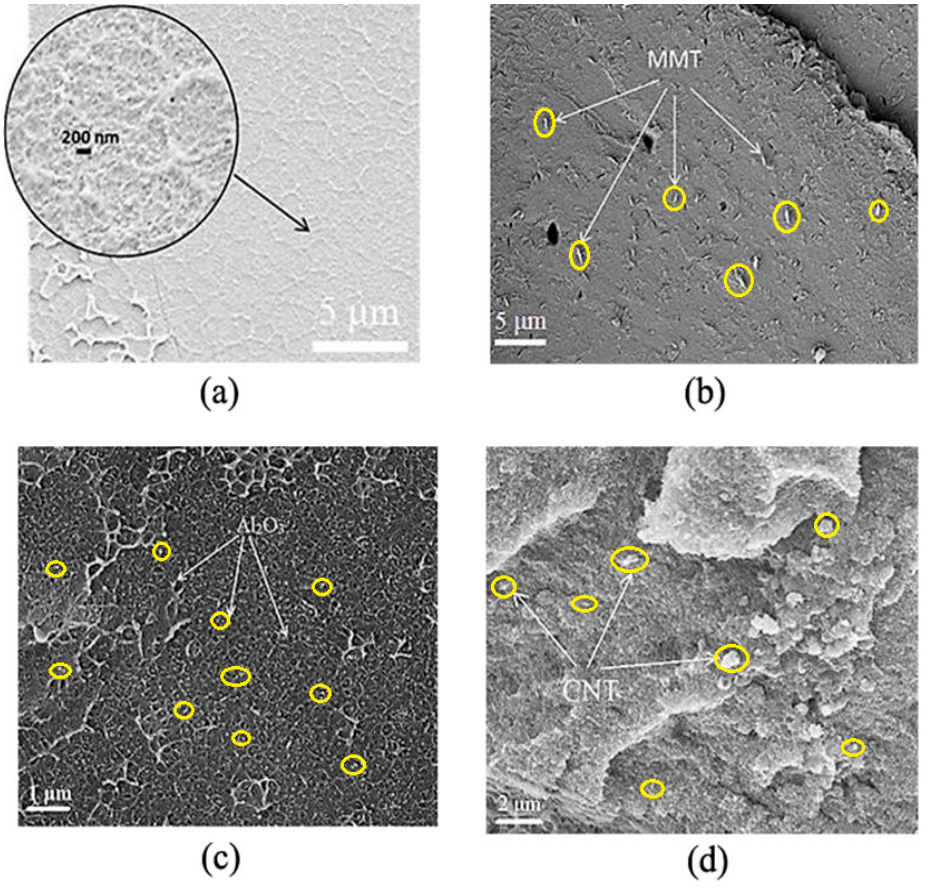
Figure 3. Microphotographs of cryo-cleaved surfaces of samples: ( a ) pure PS, ( b ) PS + 3% MMT, ( c ) PS + 10% Al 2 O 3 , ( d ) PS + 10% carbon nanotubes (CNT). Some filler particles and aggregates are depicted by arrows and yellow circles.